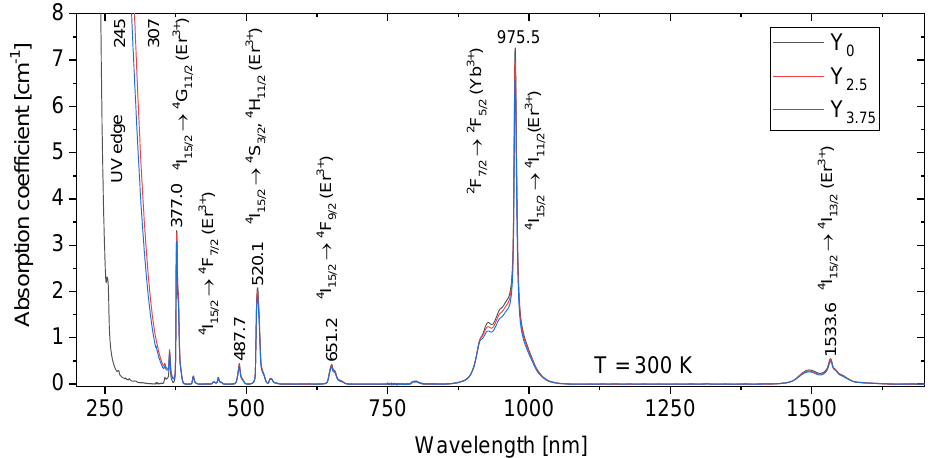
The absorption spectra are shown in Figure 4 and depict the typical absorption bands of Er 3+ ions. The absorption band at 975 nm corresponds both to the strong 4f − 4f transition 2 F 3+ ions and to the relatively weak 4 I → 2 F 7/2 5/2 of Yb An increase in the Y 2 O 3 content leads to a shift of the UV edge from 245 nm to 307 nm, probably due to the depolymerization of the phosphate network.